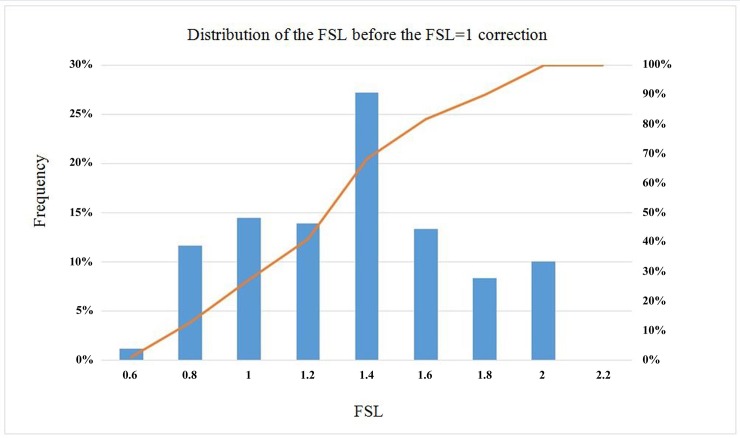
Distribution of the numerical factor of safety before correction.